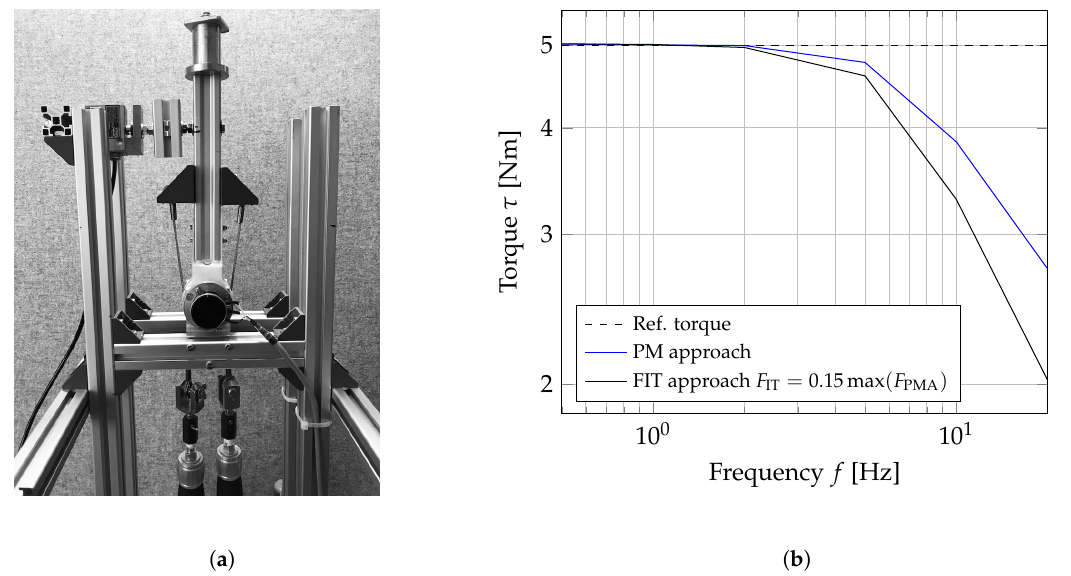
Figure 8. Torque measurement setup and measured torque data for different frequencies. ( a ) Torque measurement setup. The robot arm is fixed in an upright position and screwed to a force